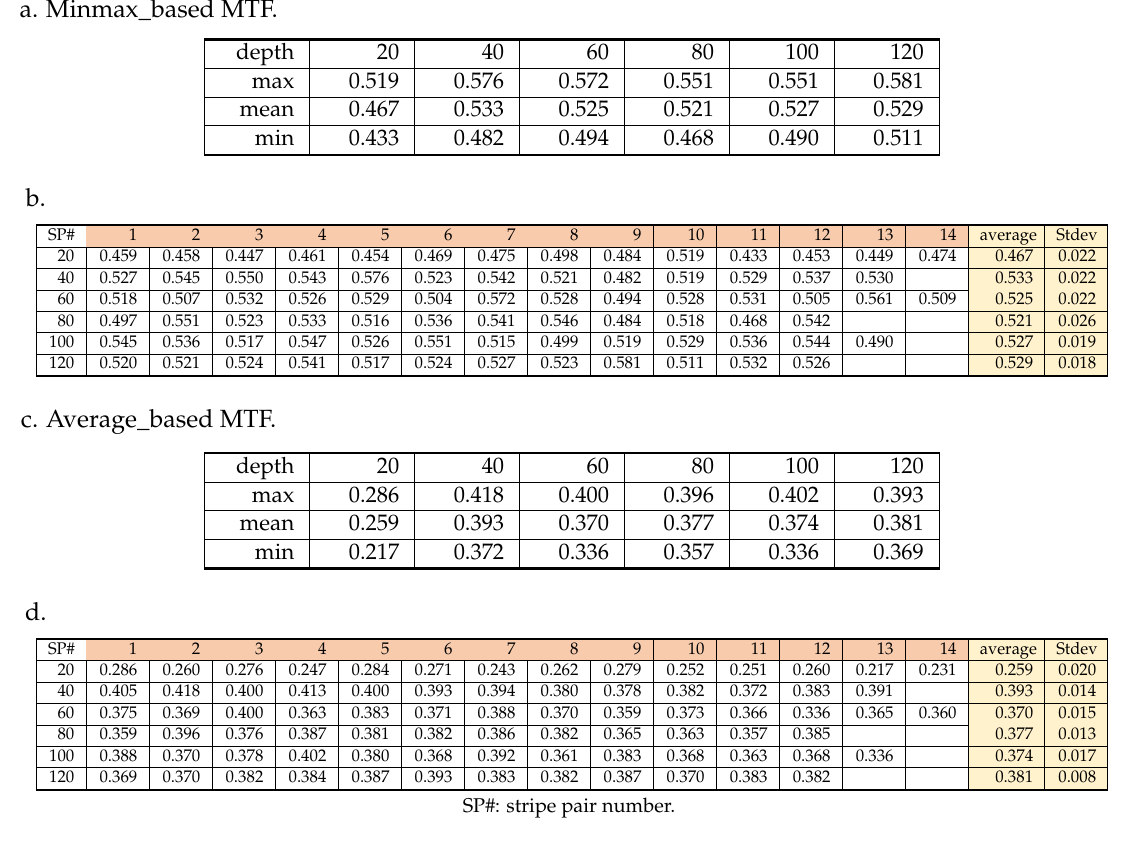
Table A1. Measured values for MTF